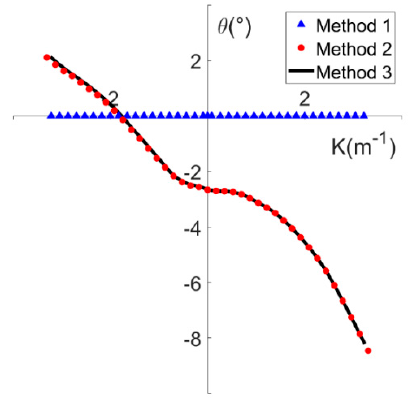
Figure 15. Rotation of neutral axis in CASE 2.